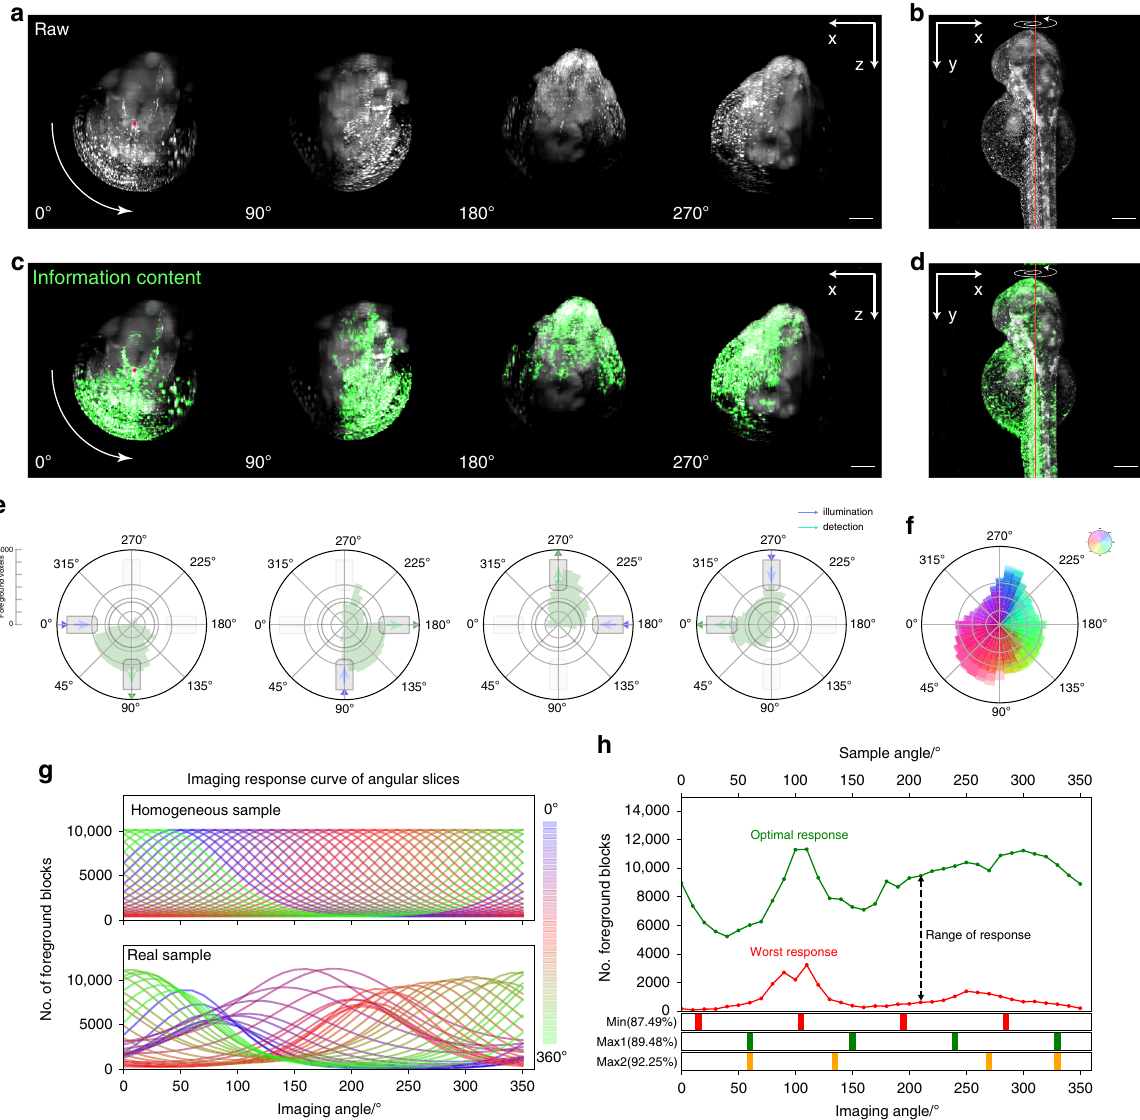
Fig. 3 Sample coverage evaluation for a zebra fi sh imaged with 24 views. a Anterior-posterior (x-z) view of the zebra fi sh embryo ( Tg(h2afva:h2afva- mCherry) ) at different angles imaged at 48 hpf. Arrow indicates the rotation direction. b Dorsal view (x-y) of the zebra fi sh embryo. c , d Information content (green) overlay with raw data (gray). Contrast adjusted with the same threshold between views. e Information content summarized by angle of different views measured by C α . f Overlaying angular information content of 24 different views, color-coded by angle. g Image response curve of angular slices comparison between a completely homogeneous sample and a real zebra fi sh embryo. Color codes the angular slice. h Top: Variation in imaging response for different angular region measured in the number of foreground blocks. Bottom: Comparison of sample coverage of 4 view multi-angle imaging strategies. Min: Minimum coverage given by 4 equally spaced views. Max1: Maximum coverage given by 4 equally spaced views. Max2: Maximum coverage with fl exibly view